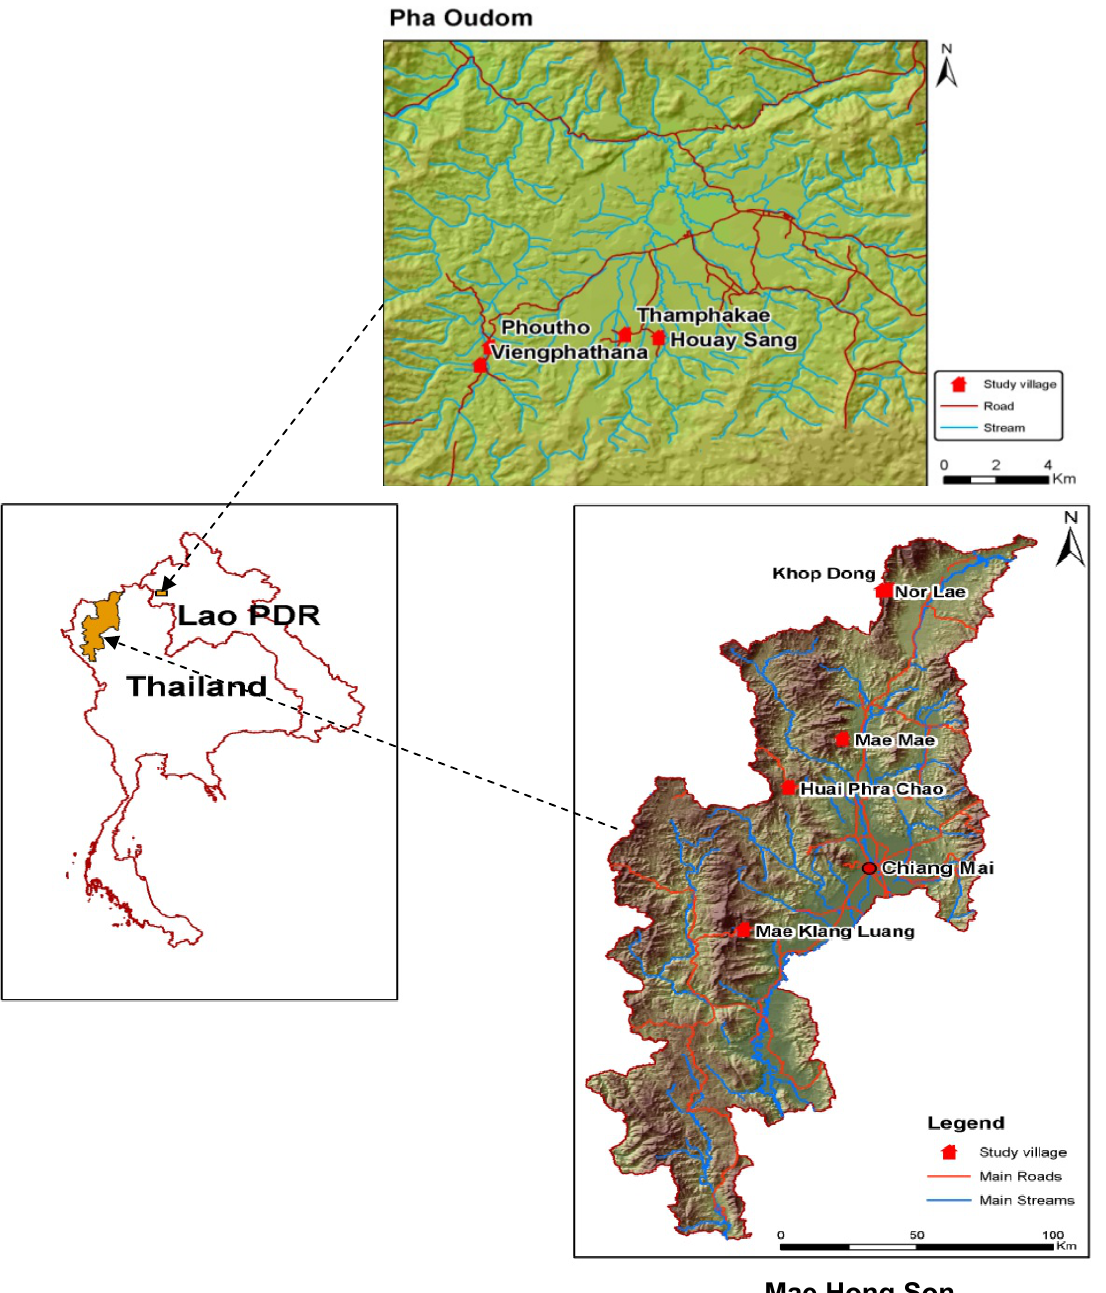
Figure 2. Research areas and location of study villages in northern Thailand and northern Lao PDR. Maps provided by Peter Elstner